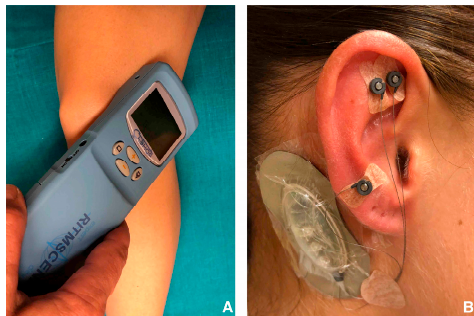
Figure 1. The EAA and LFMECT devices are presented. ( A ) Low frequency modulated electric current therapy (LFMECT) was performed using the SCENAR ® ™ device. The body acupuncture-meridians, bladder-meridian and Bachmann-points were stimulated on an outpatient basis. ( B ) For electrical auricular acupuncture (EAA) the P-Stim ® ™ device was used. Before insertion of the acupuncture needles, skin resistance was measured with an electrical conductance meter to identify the exact acupuncture points (Shen Men 55, knee 49, and cushion 29). Titan disposable auricular needles were inserted at the dominant side and connected to the P-Stim ® ™ device. Patients received continuous low-frequency EAA for 96 hours on an outpatient basis.